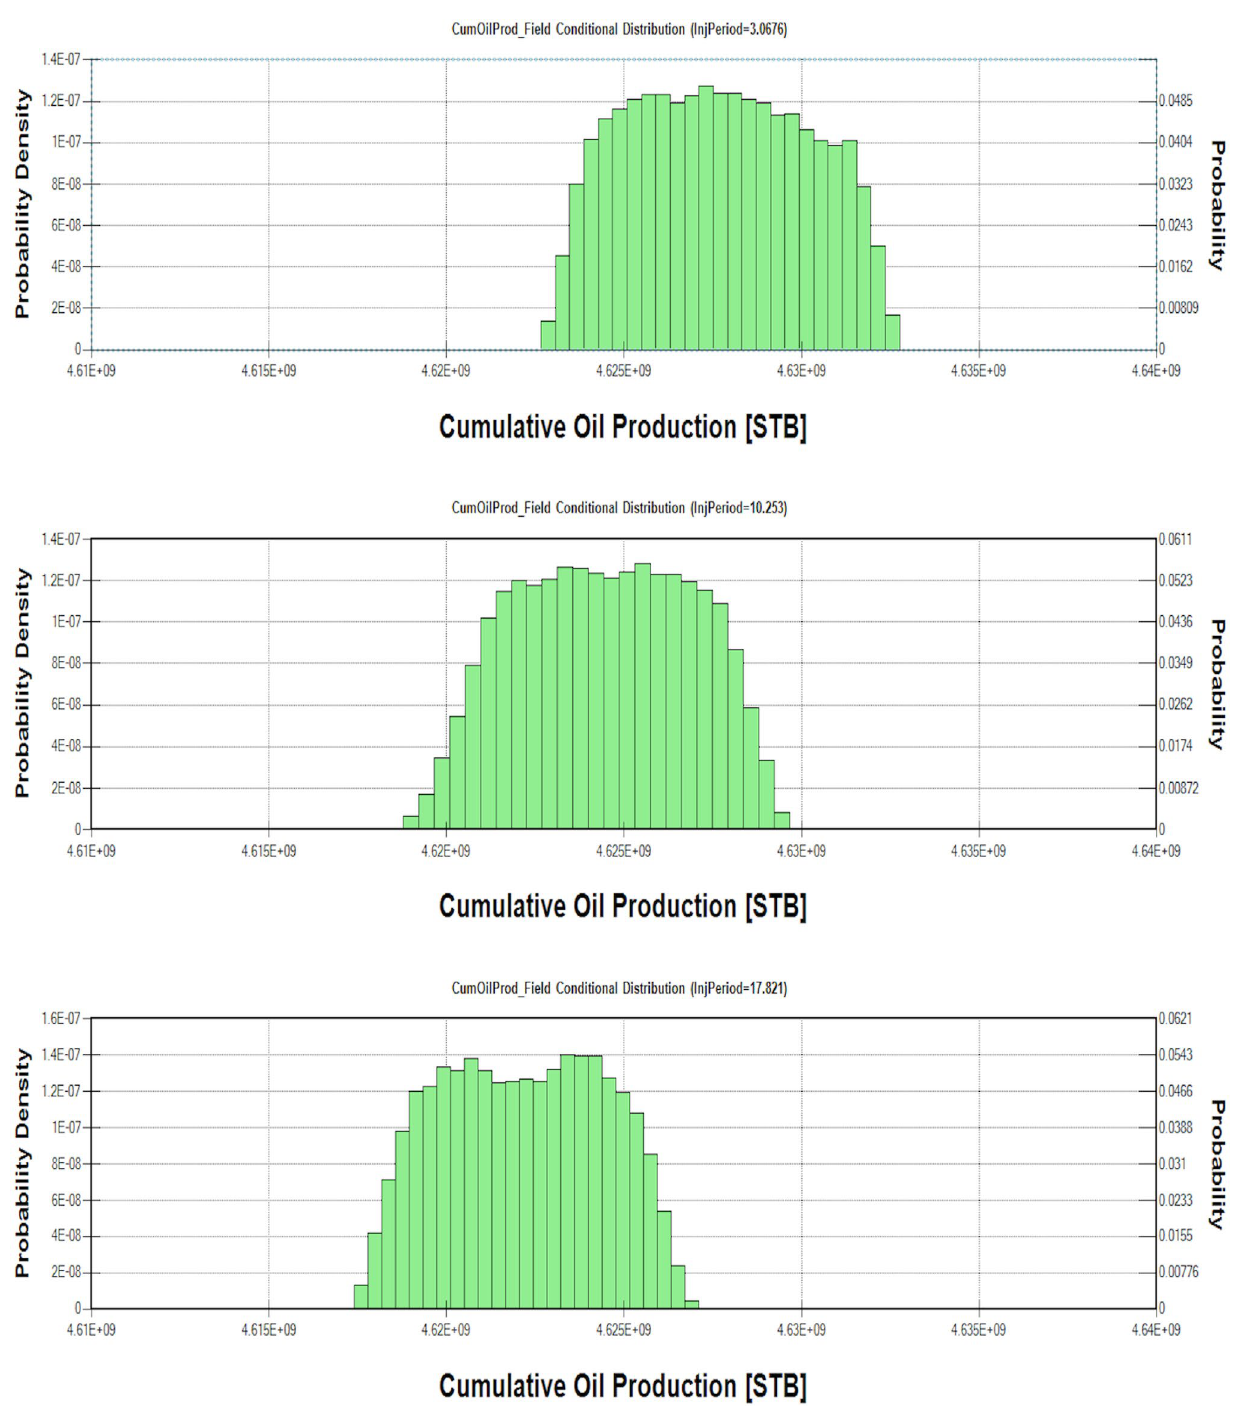
Fig. 19 Probability distribution of flow response as a function of injection